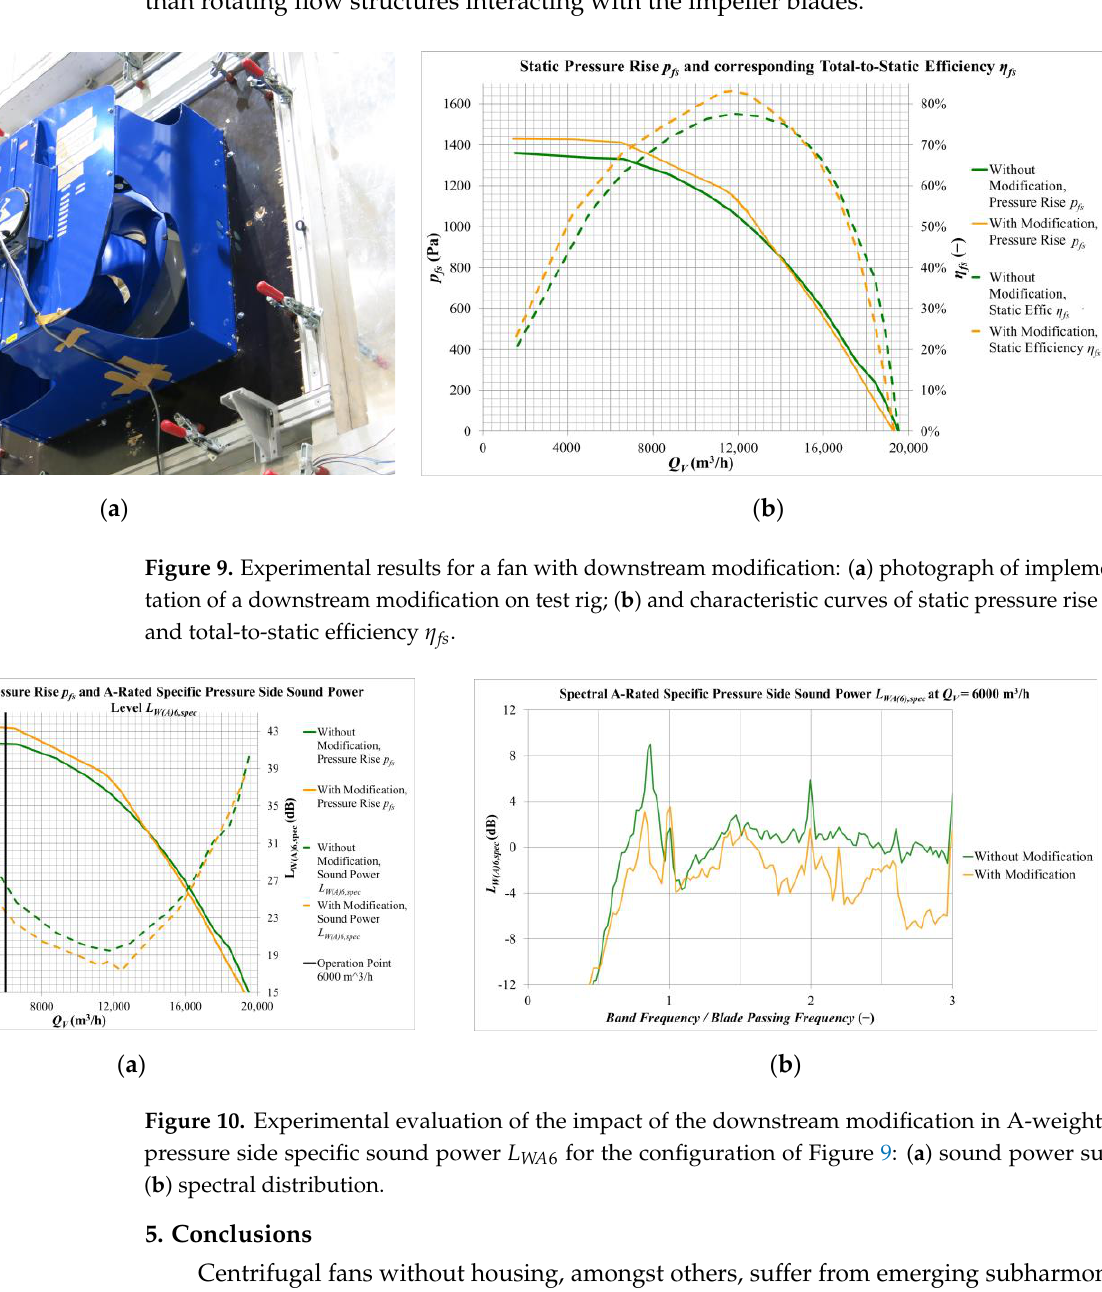
Figure 9. Experimental results for a fan with downstream modification: ( a ) photograph of implementation of a downstream modification on test rig; ( b ) and characteristic curves of static pressure rise p fs and total-to-static efficiency η fs .